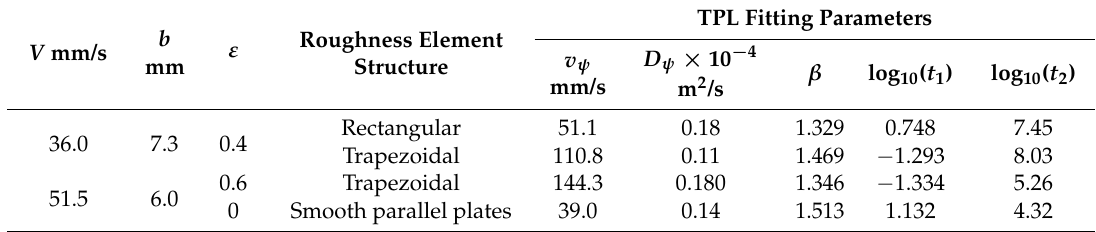
Table 10. Fitting results of the CTRW TPL model for single fractures with the same b with different roughness structure